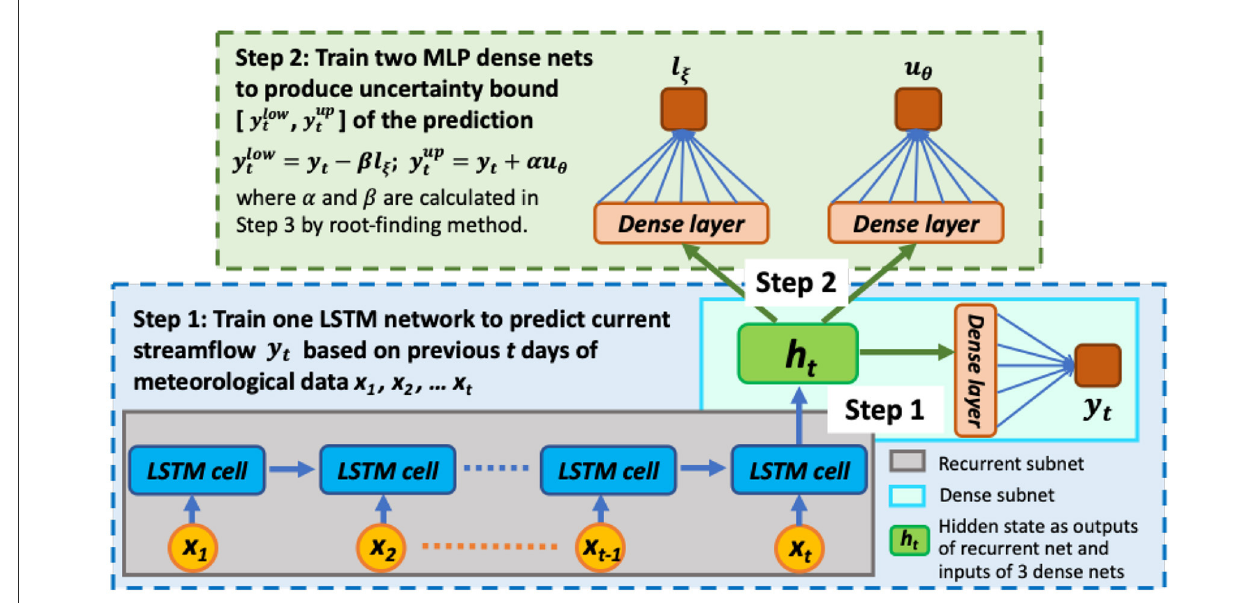
FIGURE1 The workflow of the PI3NN-LSTM method where a LSTM network is trained for prediction and two MLP networks are trained for